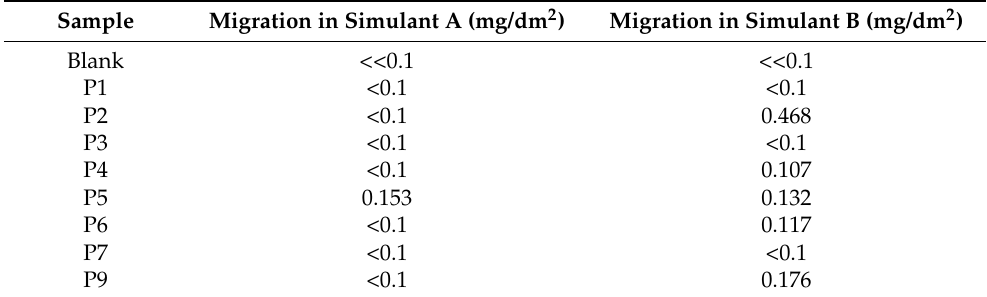
Table 5. Overall migration results of real samples in simulant A (acetic acid 3% p/v aqueous solution) and simulant B (ethanol 20% v / v aqueous solution).